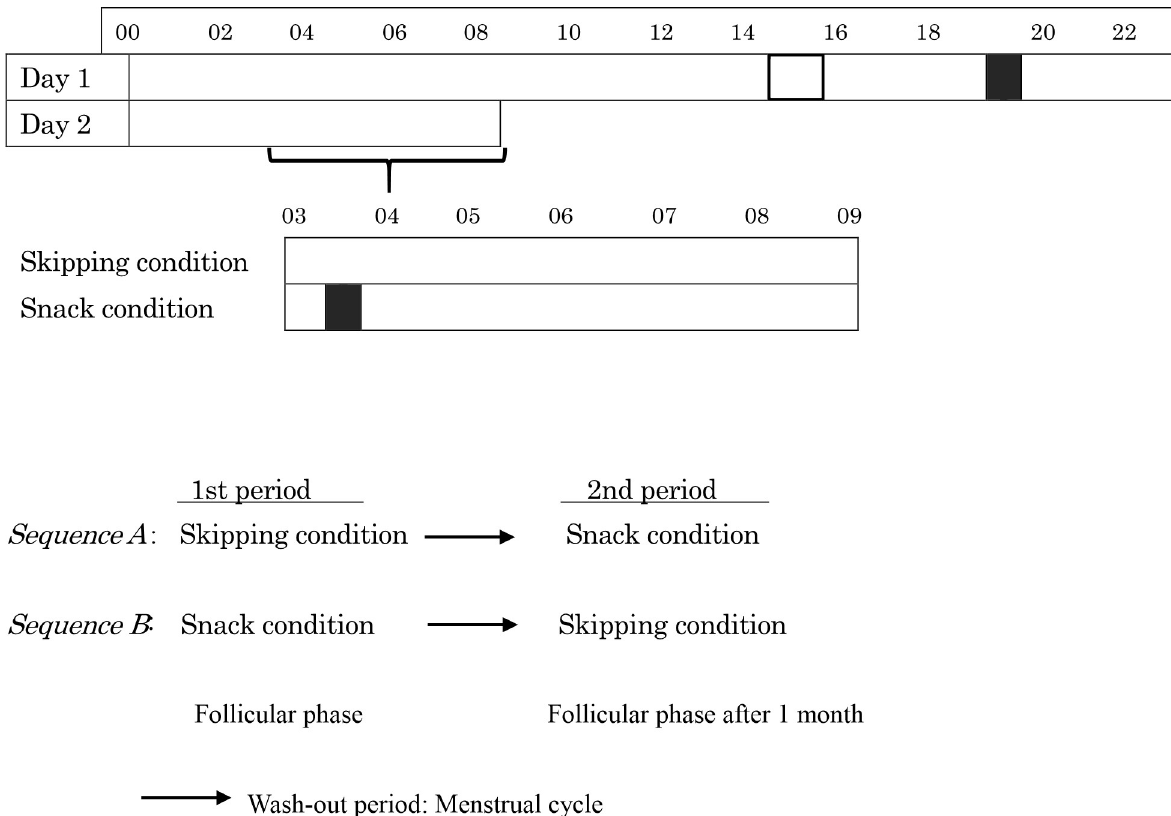
Fig 2. Schematic of the study protocol and experimental schedule. In the protocol, each row represents 24 h. The black area indicates eating time. The dotted area indicates the time of practice measurements. The diagonal hatching shows both conditions during that time period. In the experimental schedule, there are the two groups. Black arrows indicate the menstrual cycle